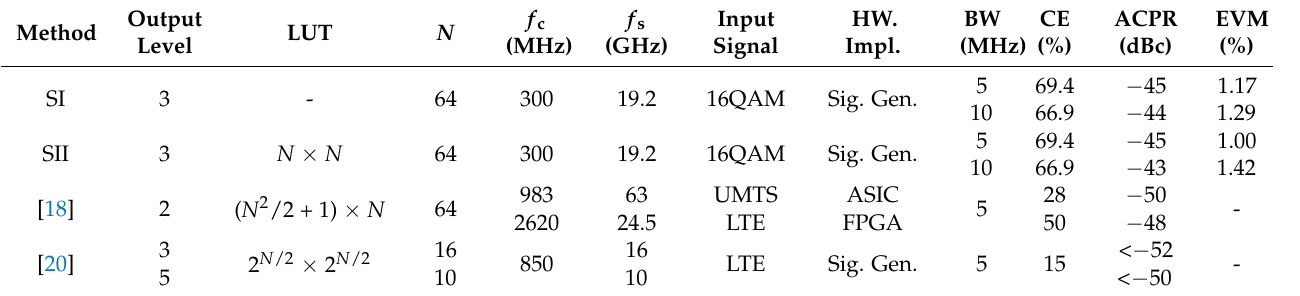
Table 1. Performance indicator comparison of two schemes and the relevant